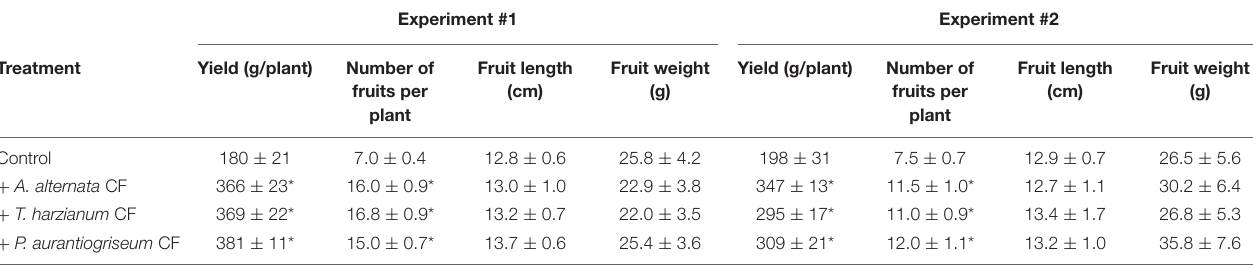
TABLE 1 | Soil application of A. alternata, P. aurantiogriseum , and T. harzianum CFs enhances commercial fruit number and yield of pepper plants (cv. Sweet Italian) cultured under greenhouse conditions.